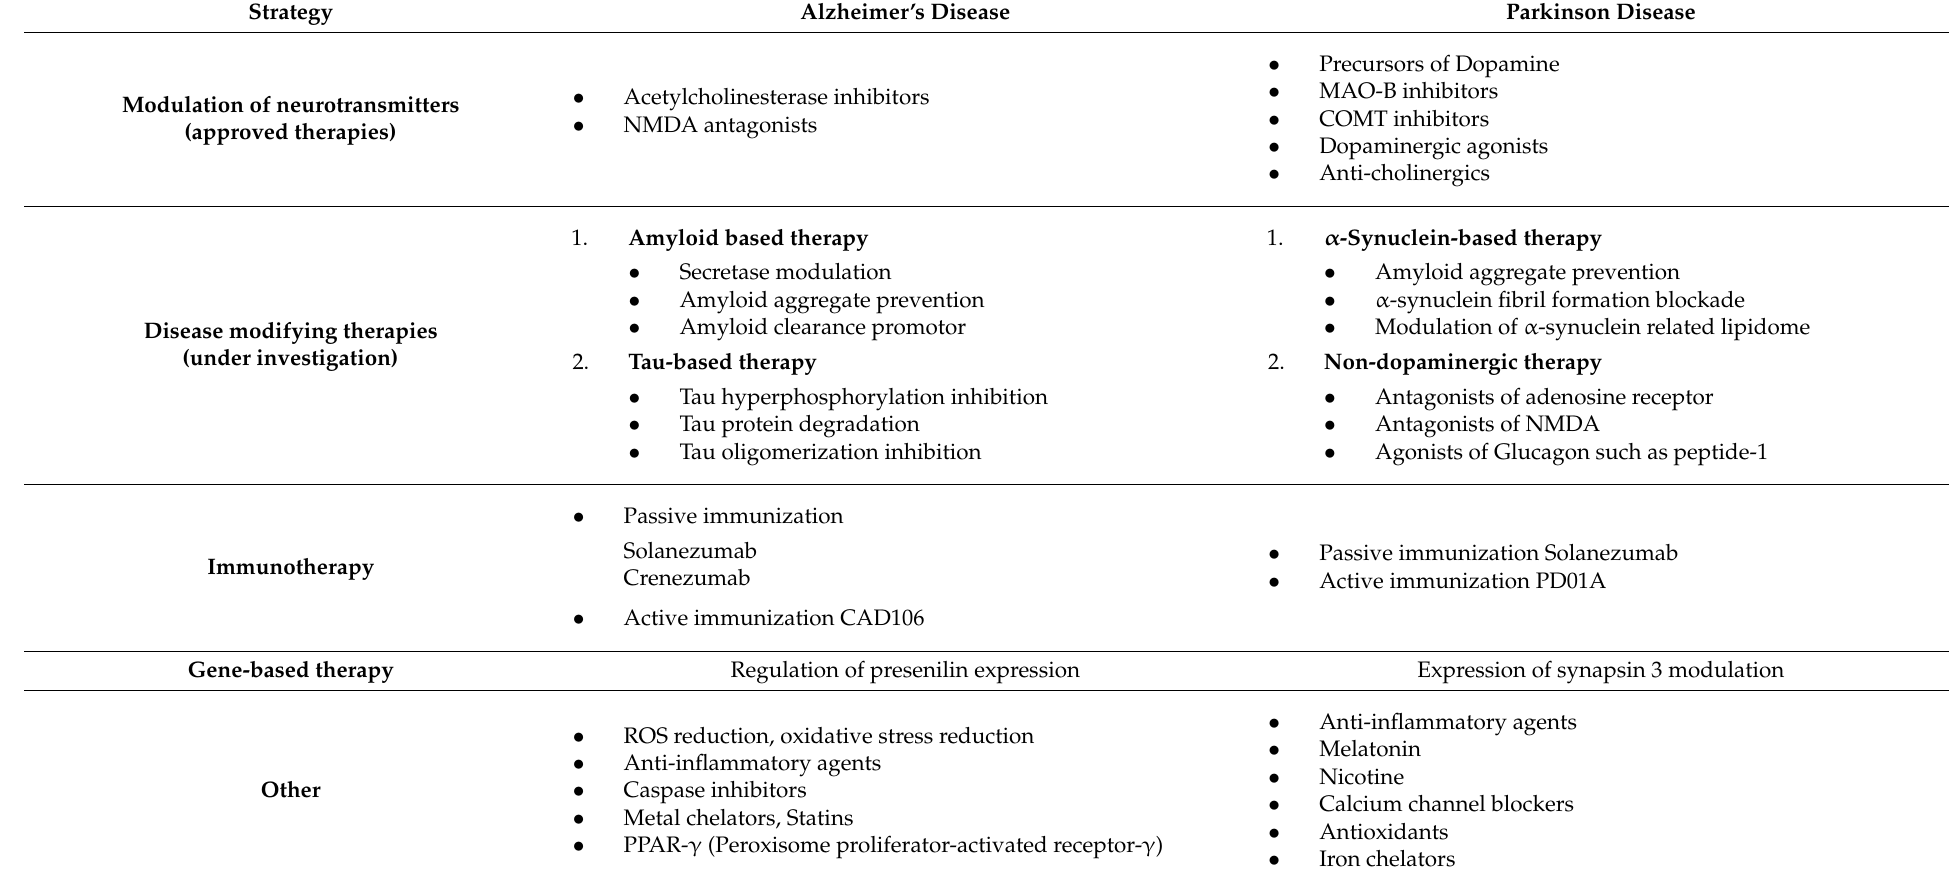
Table 1. Summary of the various conventional strategies used for the treatment of AD and